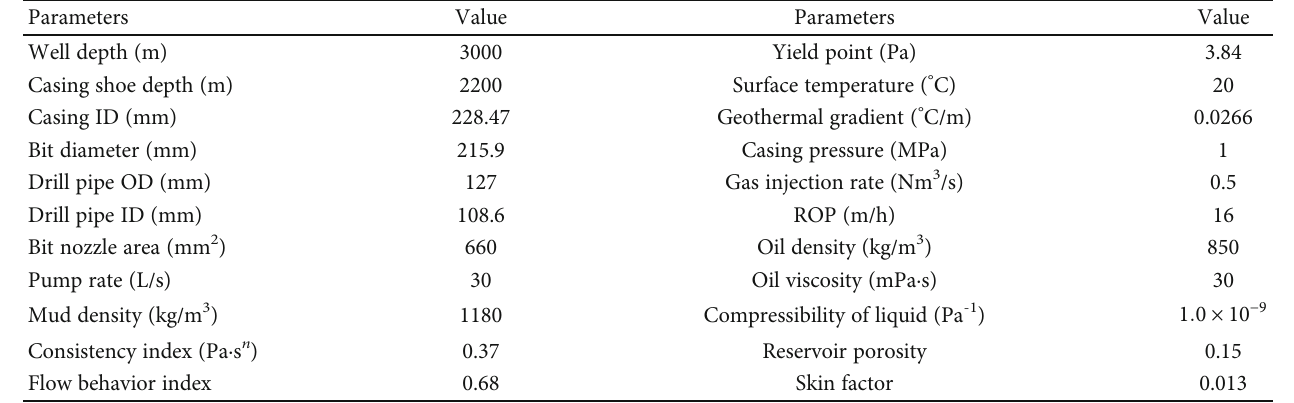
Table 1: Basic parameters for well